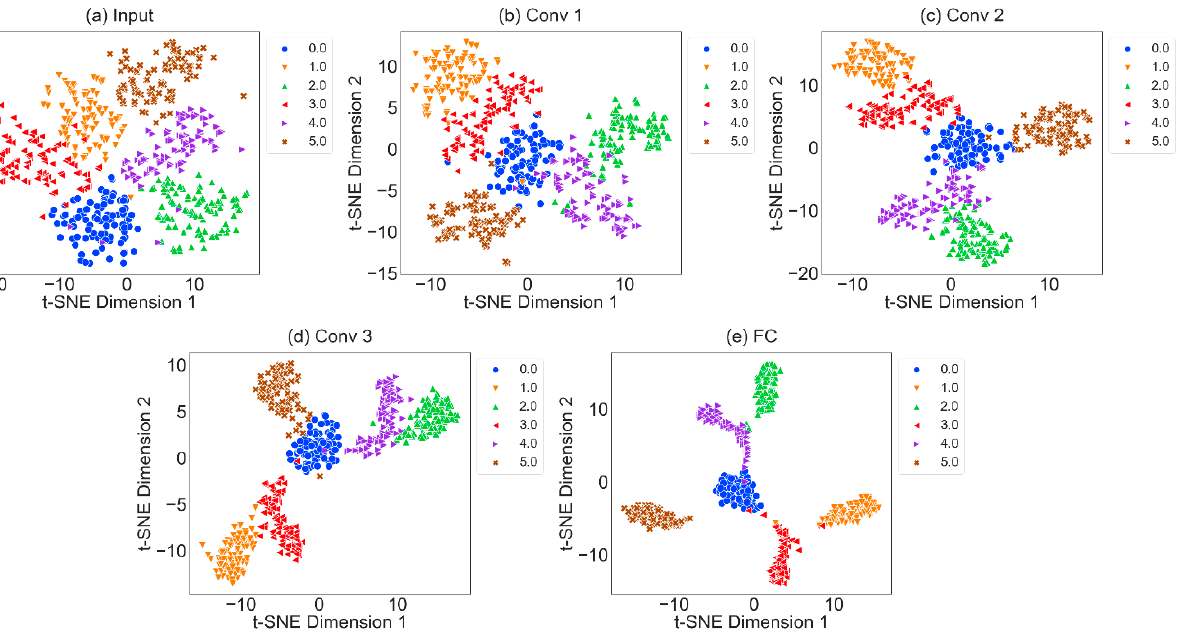
Figure 16. Visualization of the learning process for experiment 2.